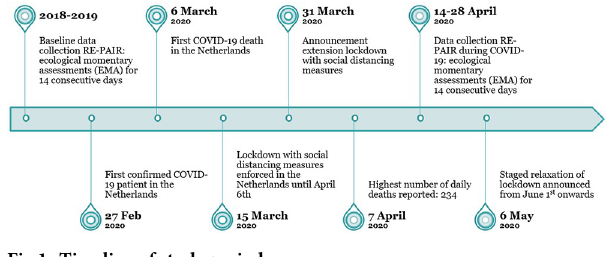
Fig 1. Timeline of study